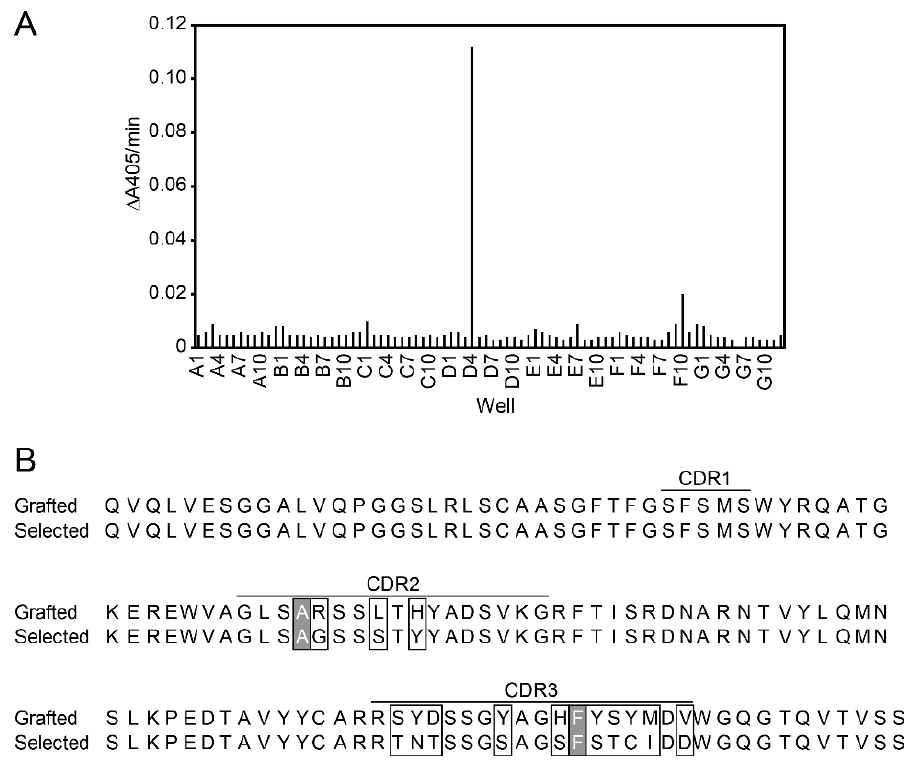
Figure 6. Affinity maturation of fluorescein-binding VHH. ( A ) ELISA screening of fluorescein binders. After two rounds of panning, fluorescein-binding VHH were expressed in E. coli and screened for their binding capability to fluorescein-conjugated BSA. ( B ) Sequence alignment of the grafted VHH and the selected VHH-D4. Thirteen out of fifteen randomized residues in CDR2 and CDR3 differ (white boxes). Alanine and phenylalanine in CDR2 and CDR3, respectively, remained unaltered (grey